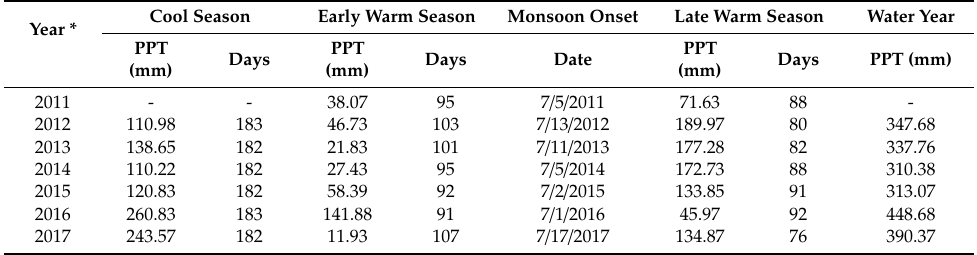
Figure 2. Time series plots of daily environmental variables measured at our study site. ( a ) Average dewpoint temperature and total precipitation; a 9.4 ◦ C threshold of dewpoint temperature was used to identify the arrival of North American Monsoon (NAM) precipitation. ( b ) Volumetric water content at two soil depths (2–17 cm and 17–32 cm) and days when snow was present (see text for details). Table 1. Summary of seasonal and water year precipitation totals (PPT) at our study site in the Sheep Range of southern Nevada (Figure